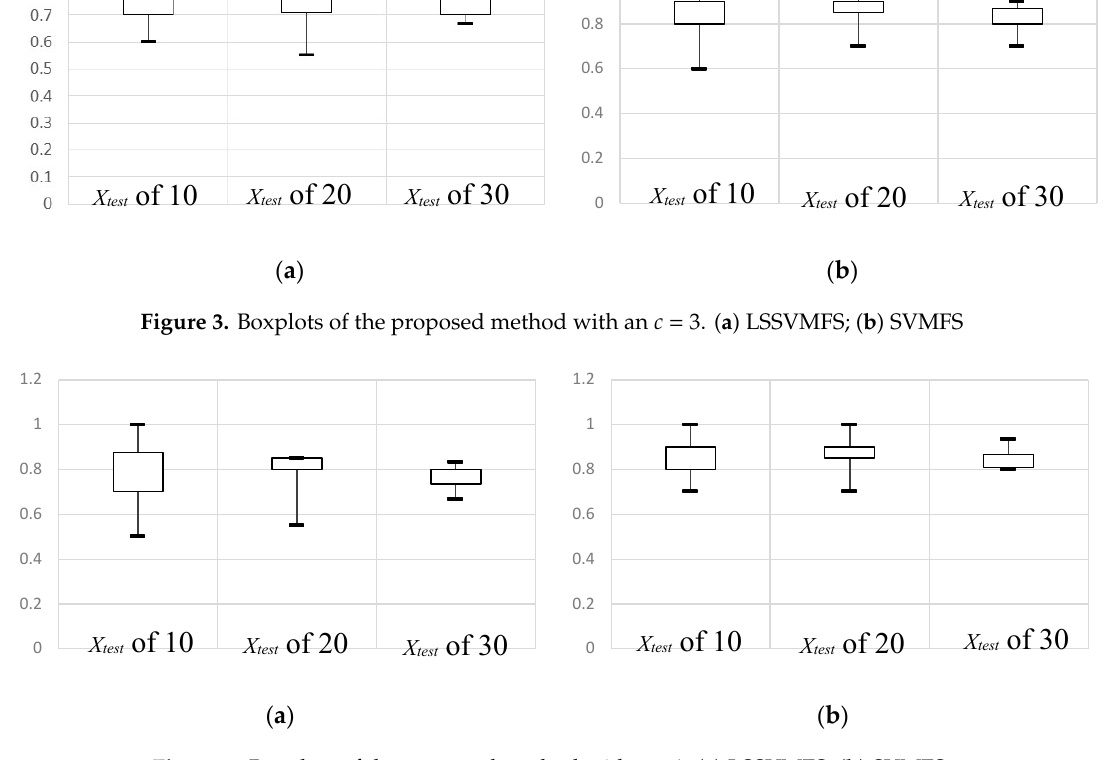
Figure 4. Boxplots of the proposed method with c = 4. ( a ) LSSVMFS; ( b ) SVMFS. Table 5. Summary of statistics and variable information of patent infringement